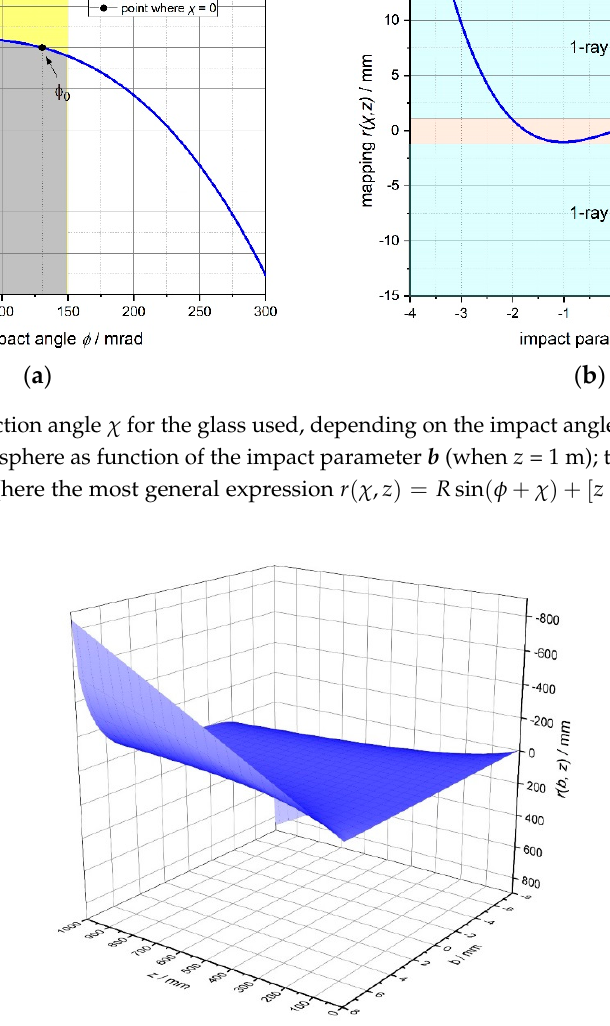
Figure 6. 3D plot of the sphere transfer function with respect to the impact parameter b and the distance z from the screen. Table 1. Fundamental equations for tracing rays of light impacting on a sphere (taken from [5]). Relation between ray (coming from the right side of the sphere) impact parameter b and impact angle φ (with R = radius of the sphere): Deflection angle of the ray exiting the sphere (Figure